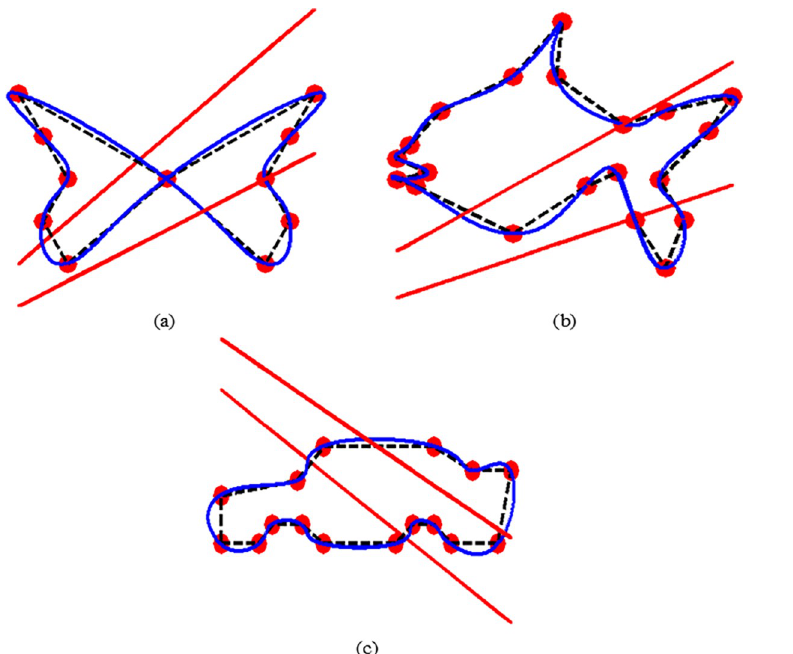
Fig 4. VDP for various object data and their corresponding QTSs: (a) Butterfly, (b) Fish, (c)